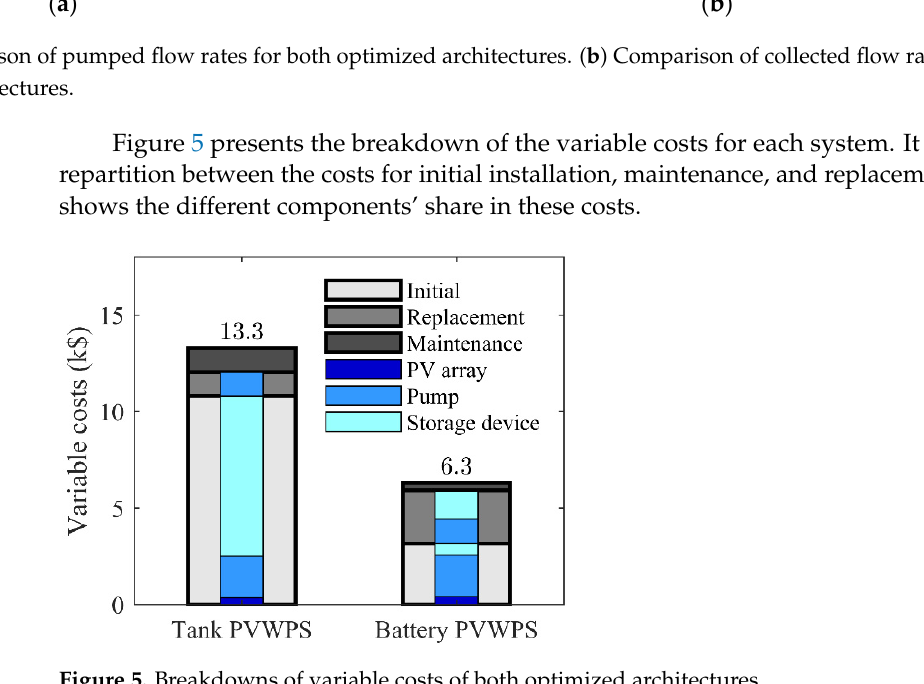
Figure 4. ( a ) Comparison of pumped flow rates for both optimized architectures. ( b ) Comparison of collected flow rates for both optimized architectures.